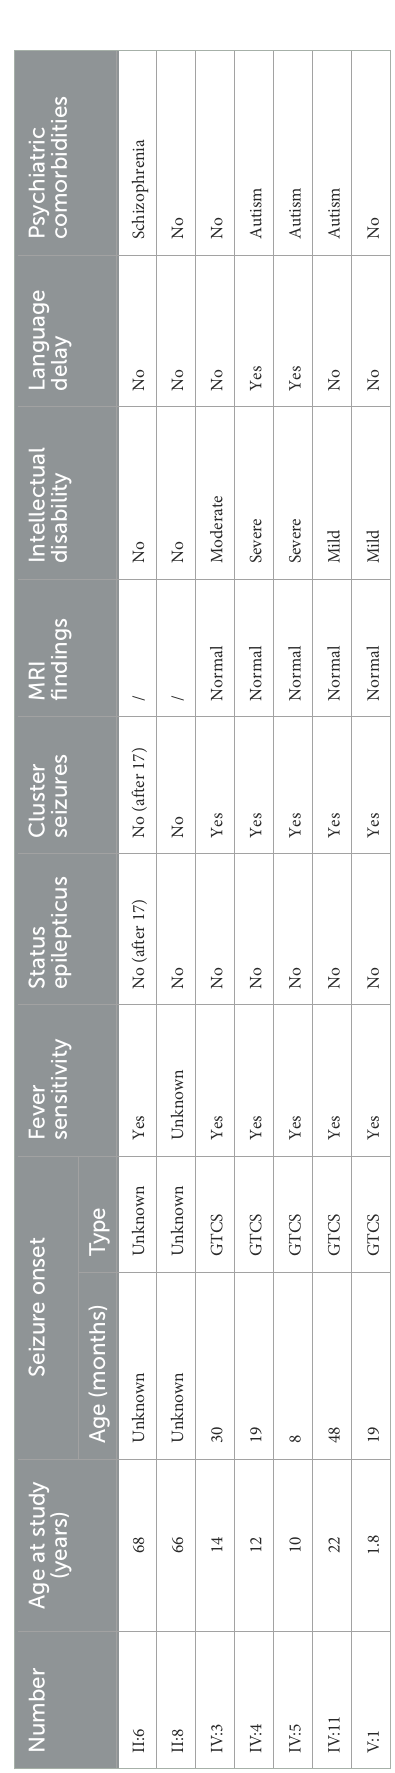
Table 1. While the first seizure age varied from 8 to 48 months, the intellectual disability level is from mild to severe damage. As for language competence, while II:6, II:8, IV:3, IV:11, and V:1 kept the normal language ability, the language delay has been observed on IV:4 and IV:5. Autism was the most common psychiatric comorbidity in our pedigree, which has been diagnosed on IV:4, IV:5, and IV:11. EEG examinations were only conducted at the first visit of these patients. With normal inter-ictal EEG, epileptic seizures were recorded during the ictal period. In summary, a strong phenotype heterogeneity has been identified in our pedigree.